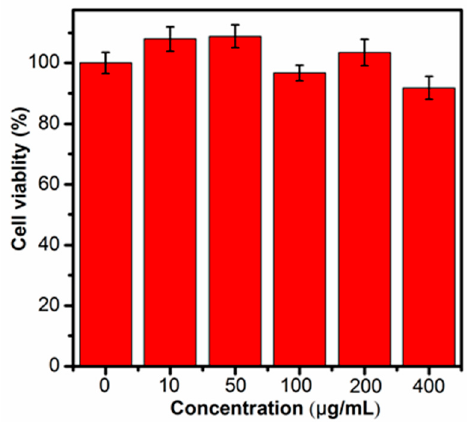
Figure 6. Viabilities after being incubated with Cu NCs in the concentrations range from 0 to 400 μ g/mL.